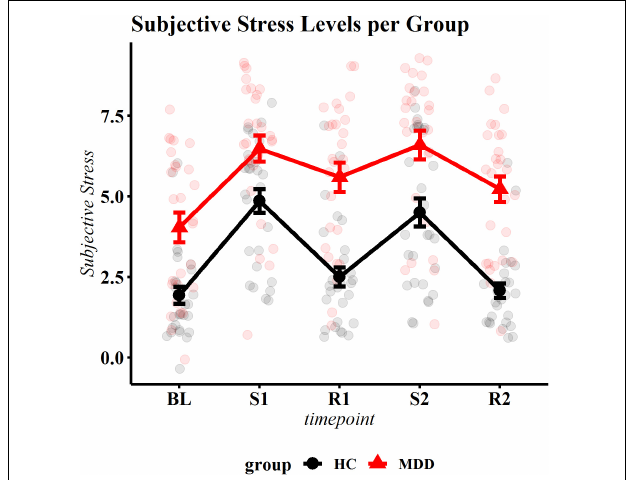
Table 2 . Of note, in an additional exploratory model within